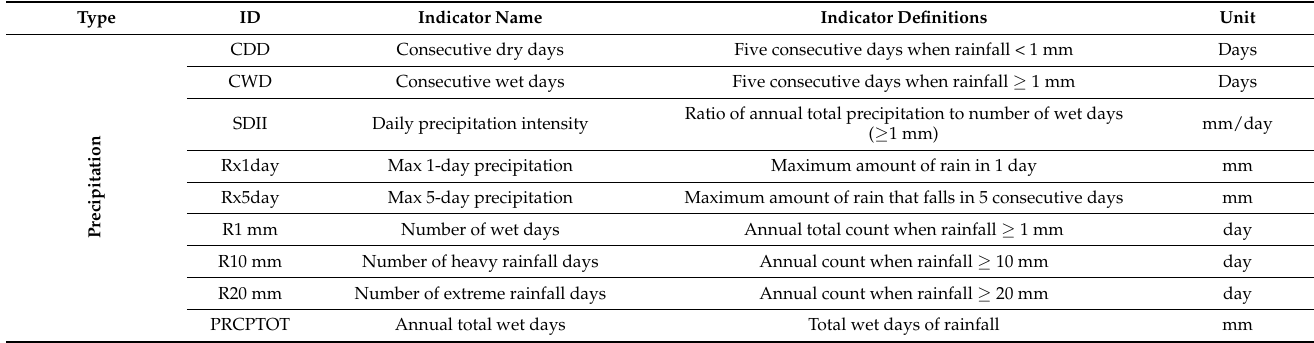
Table 2. Description of ETCCDI climate indices used in this